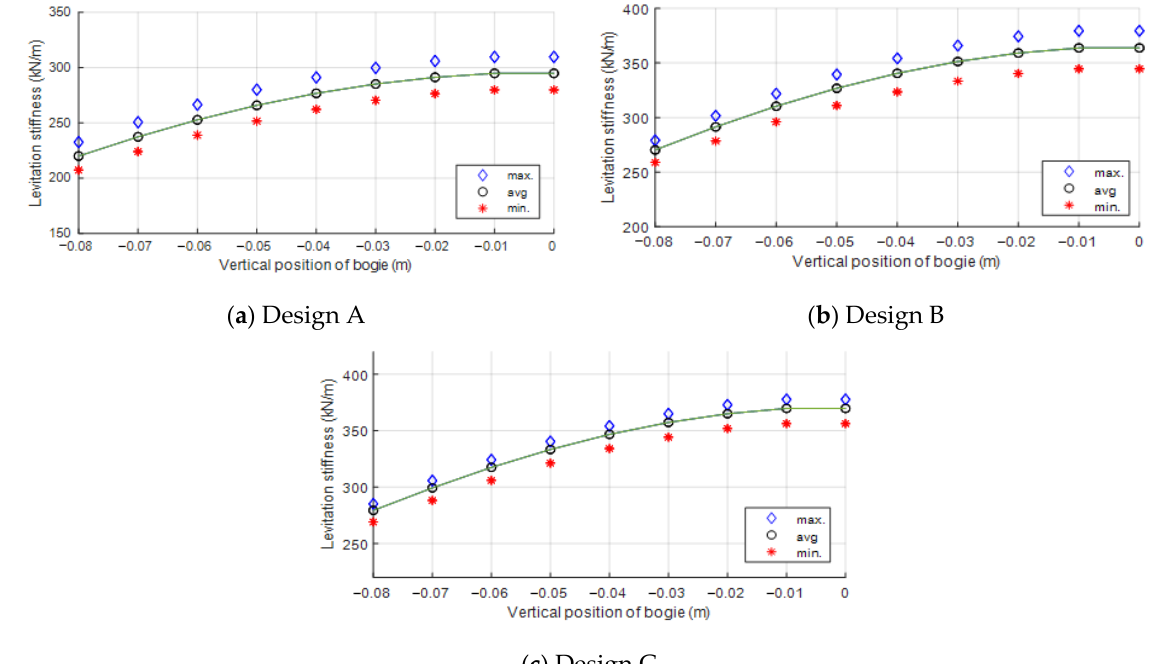
Figure 8. Relationship between levitation stiffness and vertical position (average).